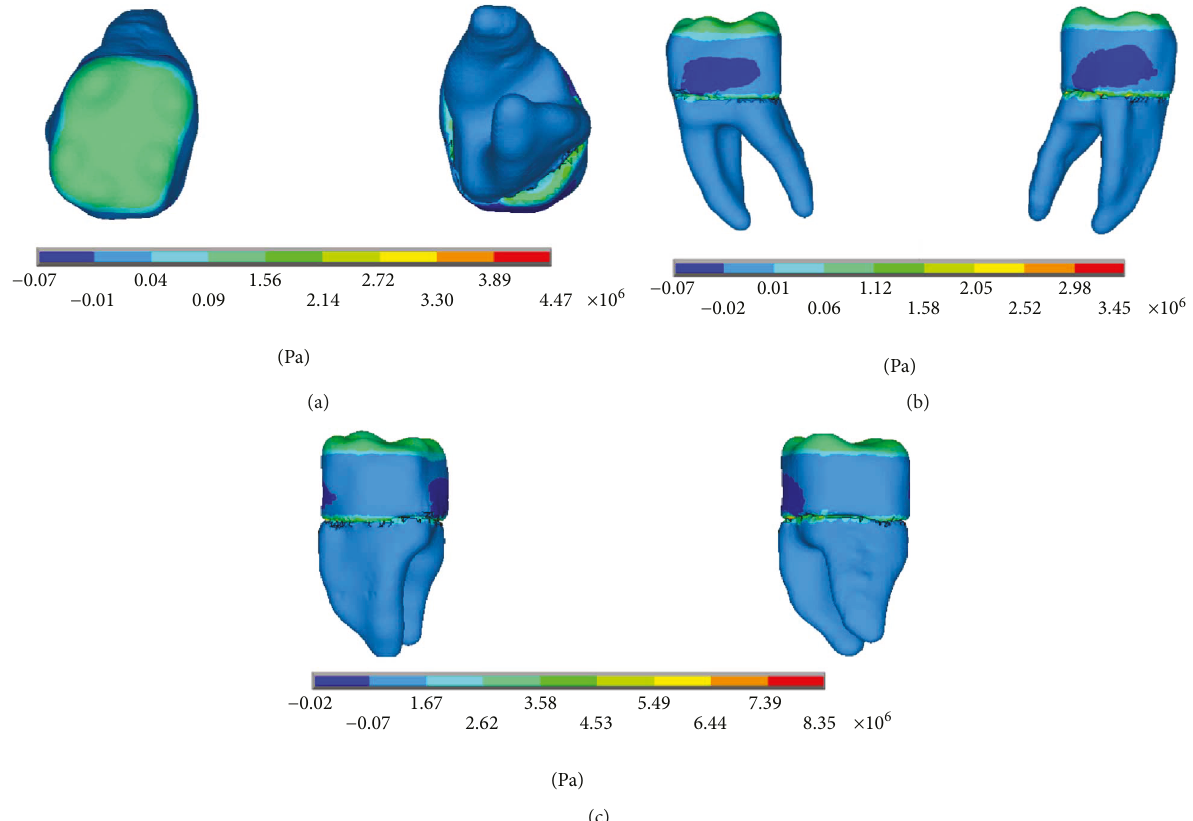
Figure 13: Nominal stress of the noncontact simulation. (a) x -axis. (b) y -axis. (c) z